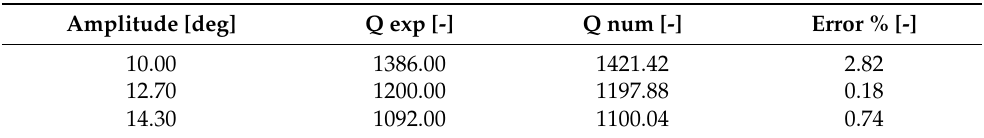
Table 5. Collection of Q factors for Micromirror 2. For each amplitude, the table reports the value of Q obtained from experimental data, the value of Q extracted form the numerical simulation, and the percentage relative error of numeric Q with respect to experimental Q